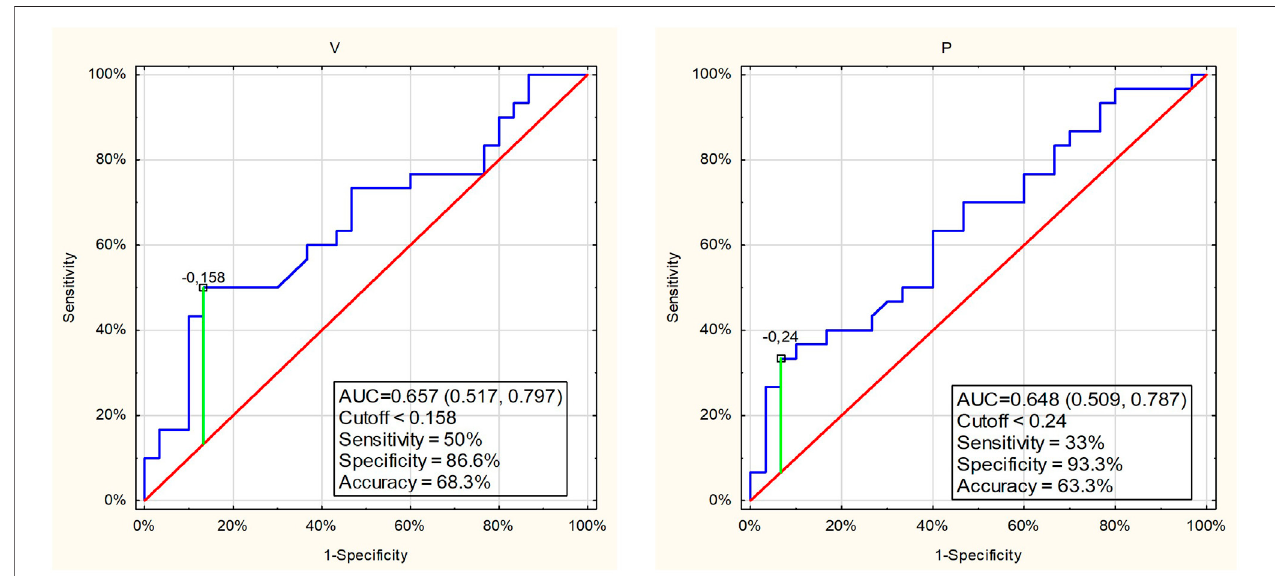
FIGURE 5 | ROC curves and cutoff values for salivary parameters those showed signi fi cant difference between the swimmers with easy or hard perceived training session load.